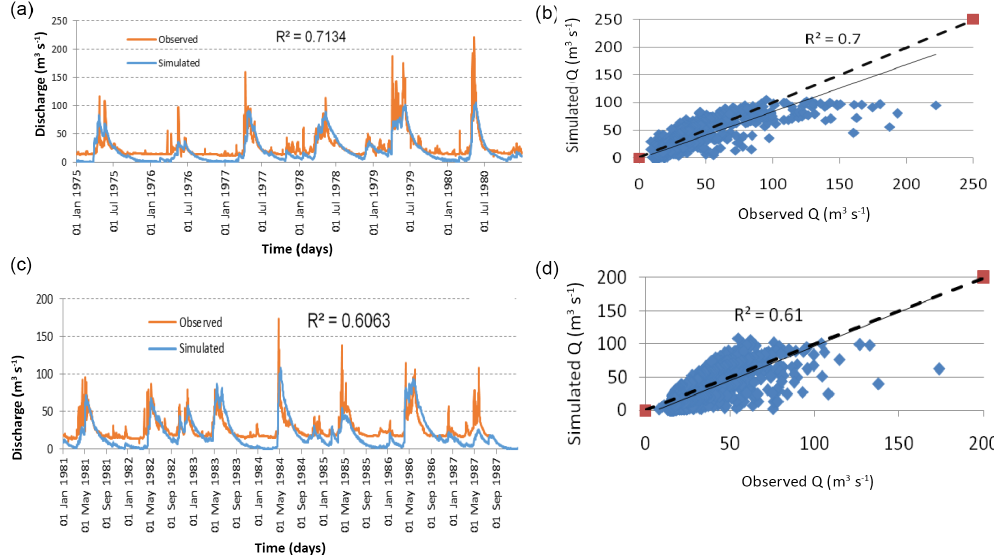
Figure 2. Calibration (a–b) and validation (c–d)